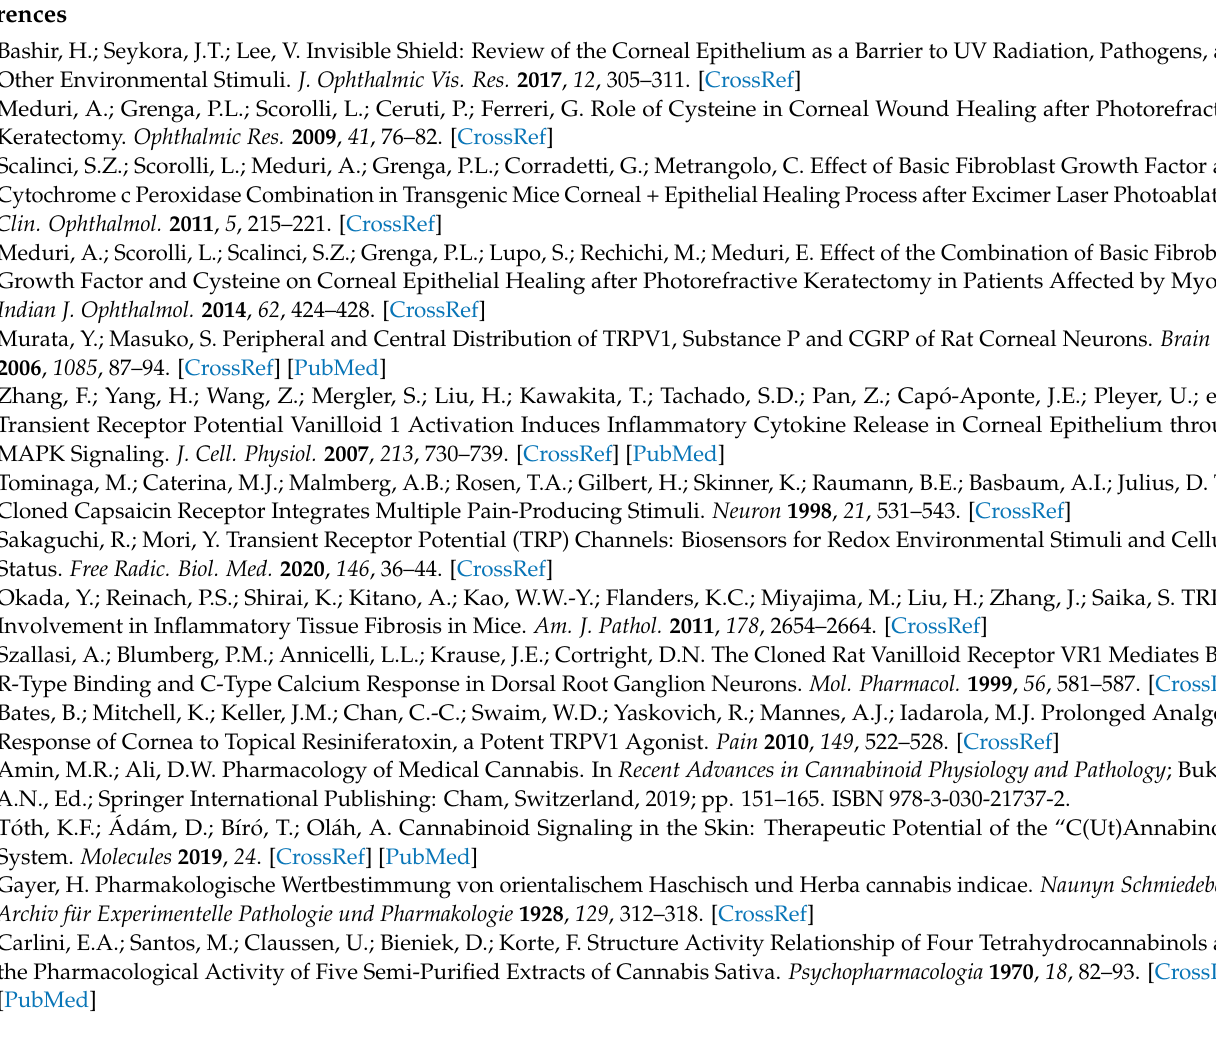
Figure A2. AEA does not influence the viability of HCECs. Determination of cell viability by colorimetric MTT (3-(4,5-dimethylthiazol-2-yl)-2,5-diphenyl tetrazolium bromide) cell viability assay. Data (mean ± SEM) are expressed as a percentage of the mean value (defined as 100%) of the vehicle-treated group. Three additional experiments yielded similar results.